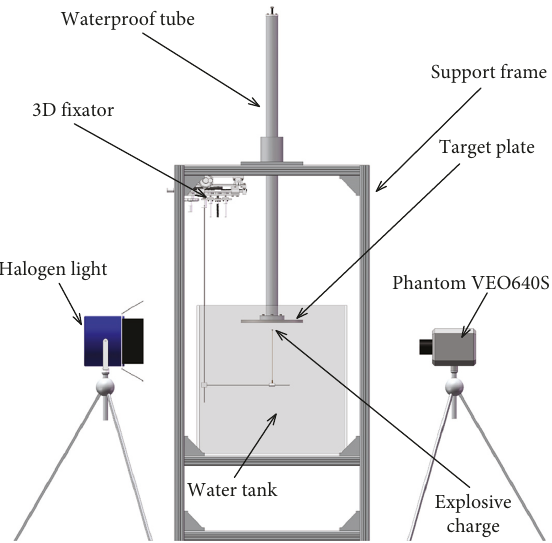
Figure 1: Schematic of the test system.